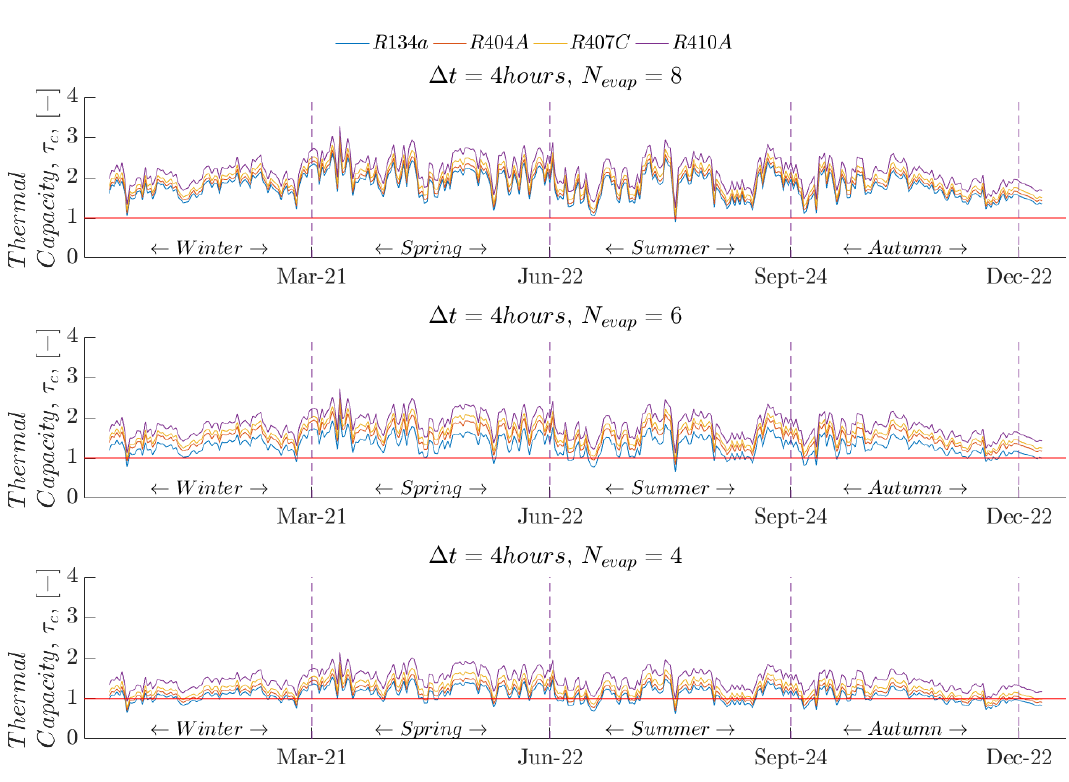
Table 4. Average annual thermal capacity during 4 hours of operation.